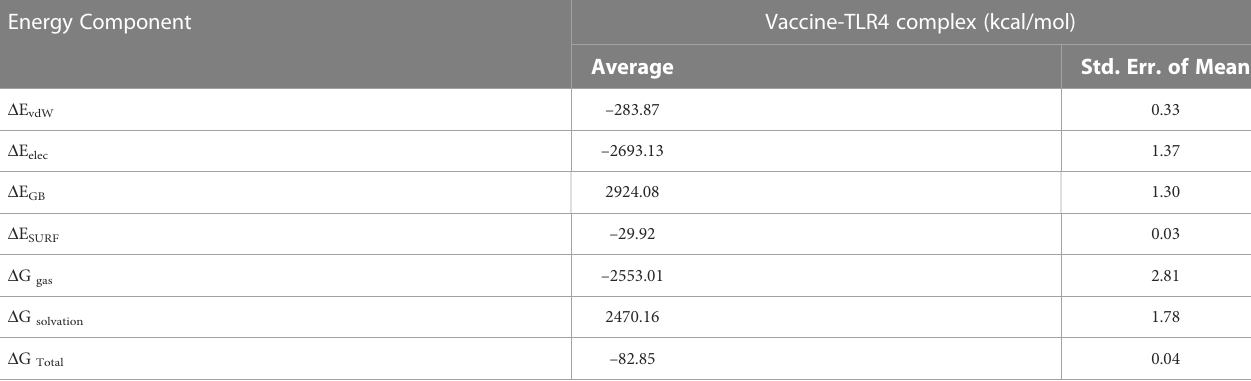
TABLE 6 MM/GBSA free energy calculations and individual free energy components of the constructed vaccine TLR4 complex. Differences (Complex - Receptor - Ligand). Energy